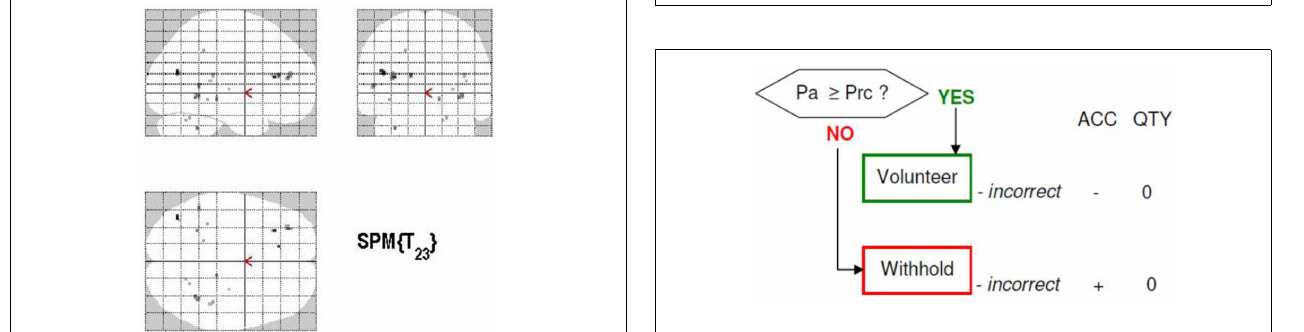
FIGURE 10 | Memory accuracy and inaccuracy according to the memory paradigm (cf. Figure 1 for